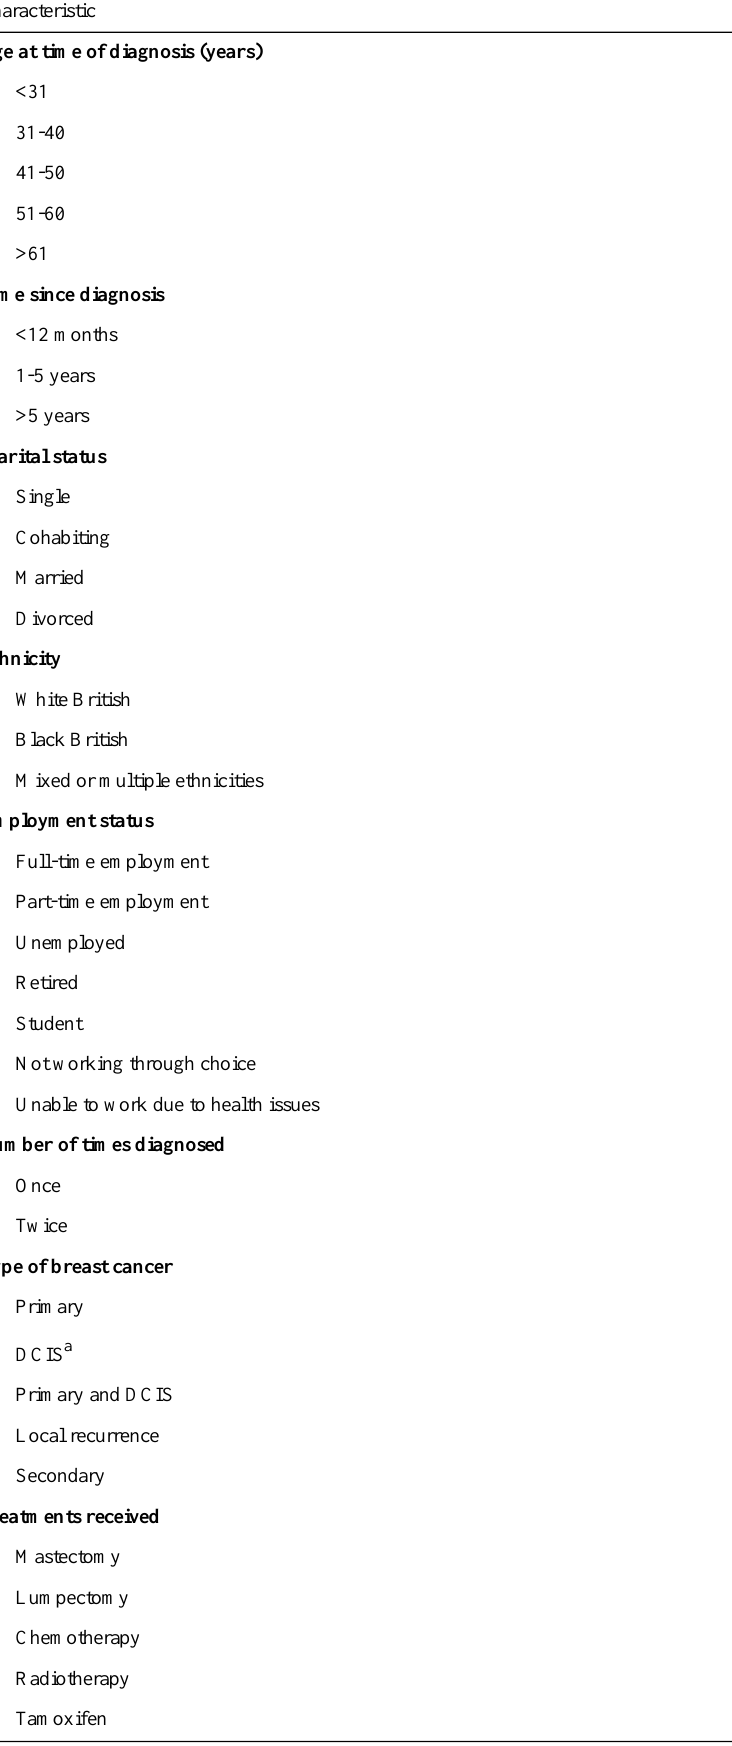
Table 1. Participants’characteristics